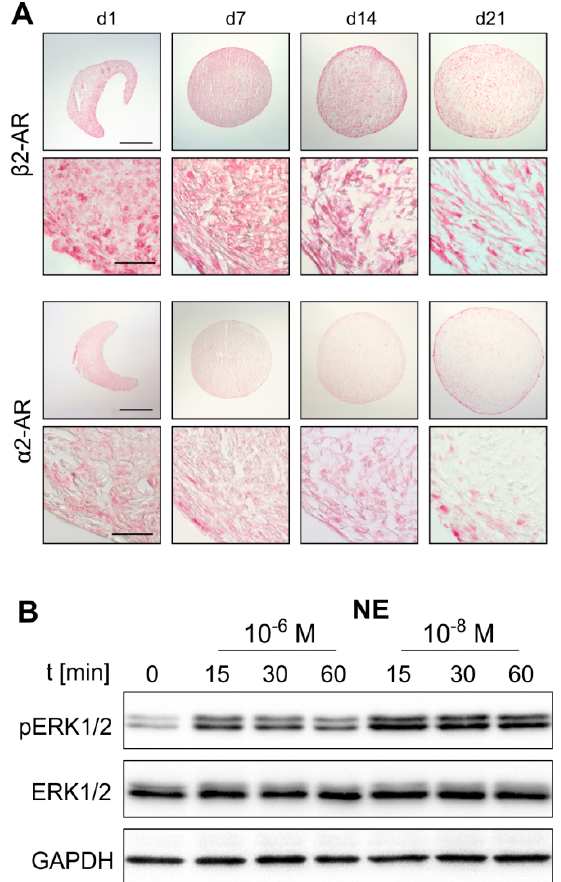
Figure 3. AR protein expression during sASC chondrogenesis and norepinephrine (NE)-mediated activation of intracellular signaling. ( A ) Immunohistochemical analysis of β 2-AR and α 2a-AR during sASC chondrogenesis on days 1, 7, 14, and 21 of differentiation (bars, 500 μ m in upper panels and 50 μ m in lower panels). ( B ) Western blot analysis of total ERK1/2 as well as ERK1/2 phosphorylation in chondrogenic sASC culture in the absence or presence of NE (10 − 8 M and 10 − 6 M, representative blot of one OA patient).